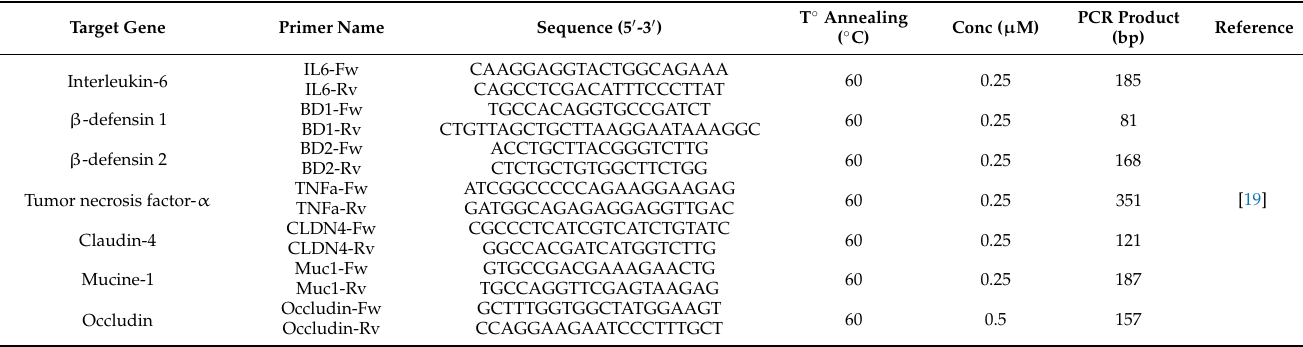
Table 1. Primers and PCR conditions (T ◦ of annealing ( ◦ C), optimal primer concentration ( µ M), and PCR product (bp)) for the selected target genes. Fw: forward; Rv: reverse; bp: base pairs